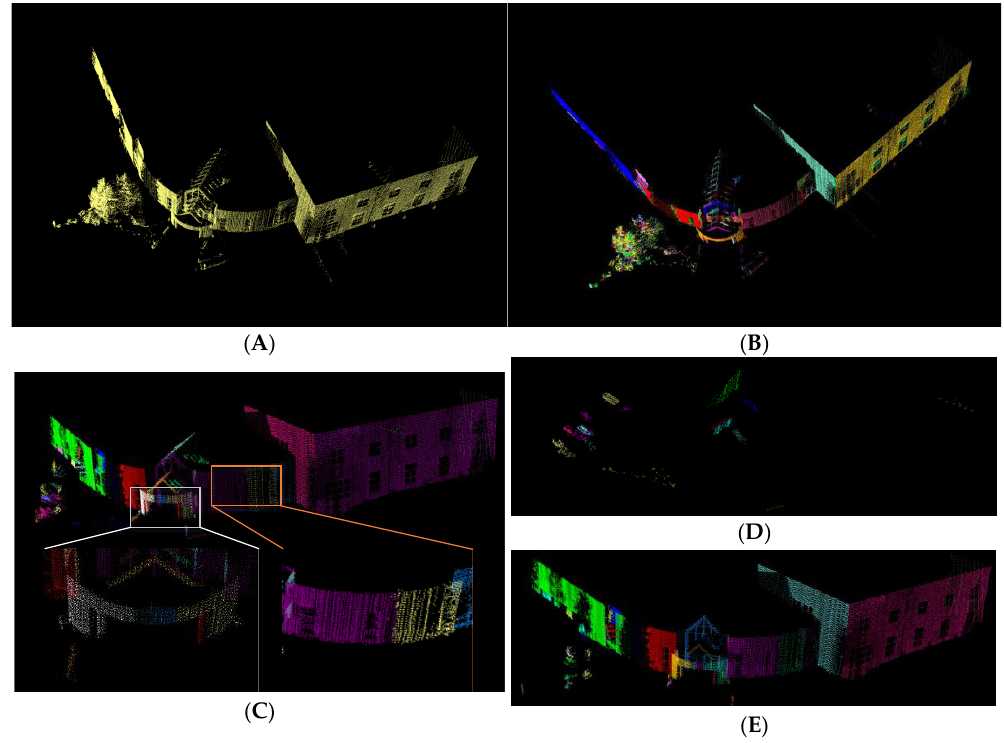
Figure 15. Recognition of semantic features of the components of a building from point cloud. ( A ) A cluster; ( B ) planar segments after region growing processing; ( C ) planes detected by RANSAC algorithm using plane models; ( D ) a potential roof structure; ( E ) a potential wall structure.